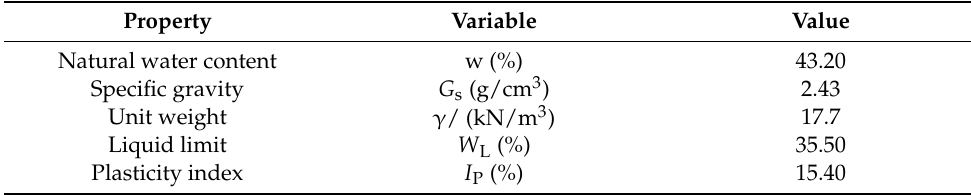
Table 1. Physical characteristics of